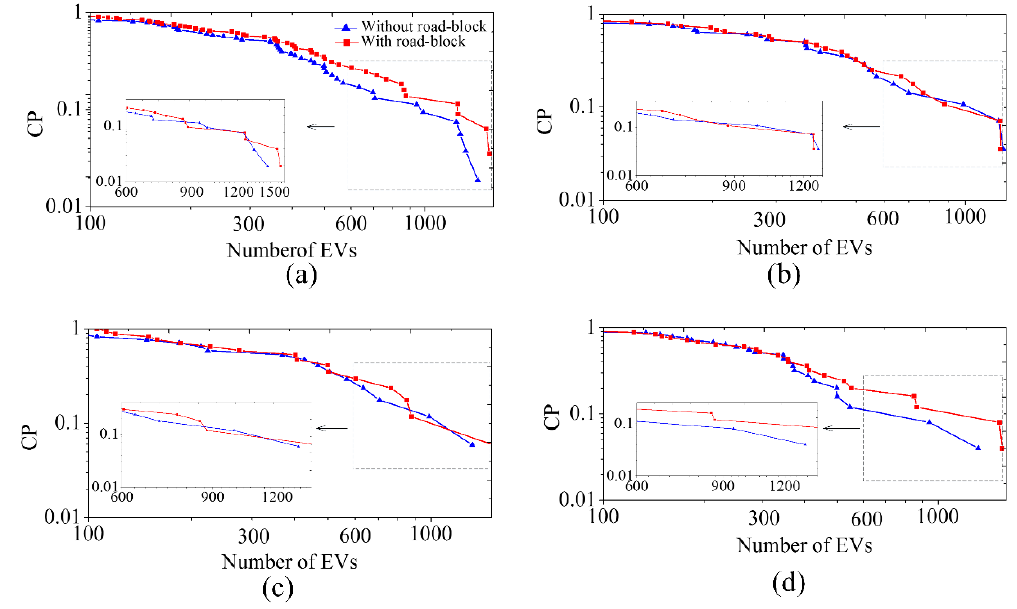
Figure 8. Cumulative distribution function (CDF) of EVs ( a ) in the transportation networks, ( b ) in the industrial area, ( c ) in the business zone, and ( d ) in the residential district. In general, the more consistent the red and blue lines, the more alike the traffic conditions.